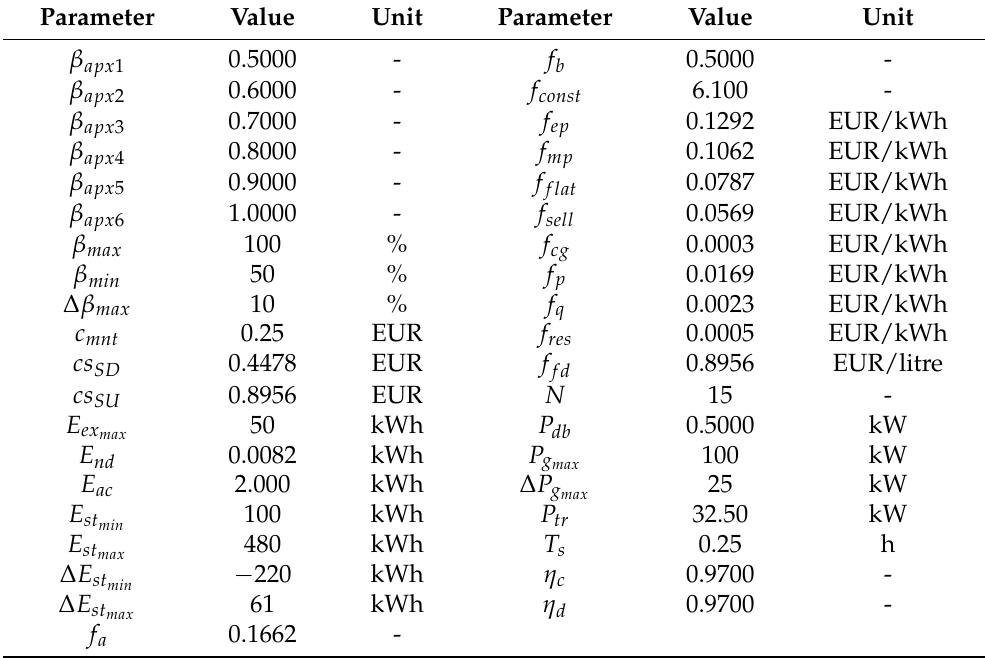
Table 1. Microgrid model parameters and